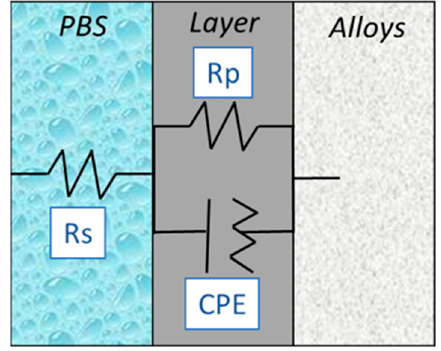
Figure 7. The equivalent electrical circuit model. Table 3. Parameters obtained from the equivalent circuit model.